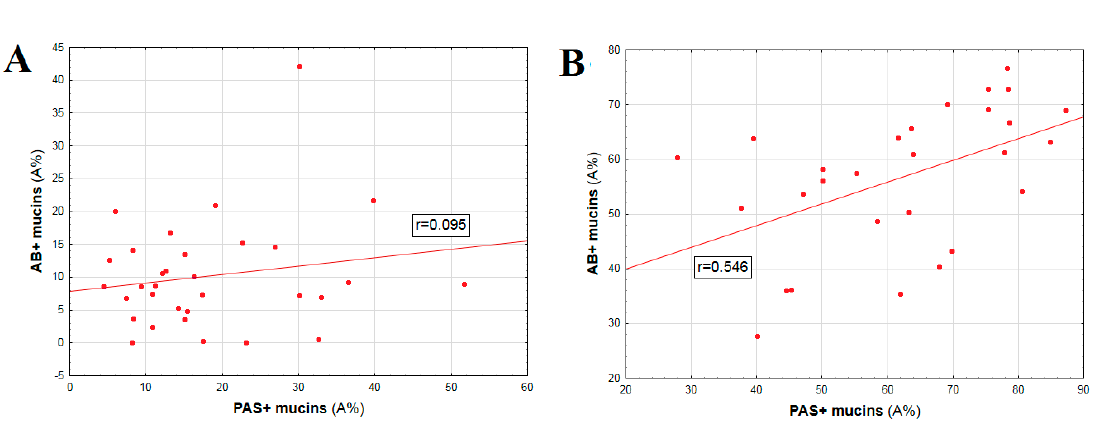
Table 6. Values of Spearman’s coefficient for correlation between both types of polysaccharides expression (PAS+, AB+) in colorectal carcinoma (CRC), unaltered colorectal tissue samples (control) and selected clinical data.